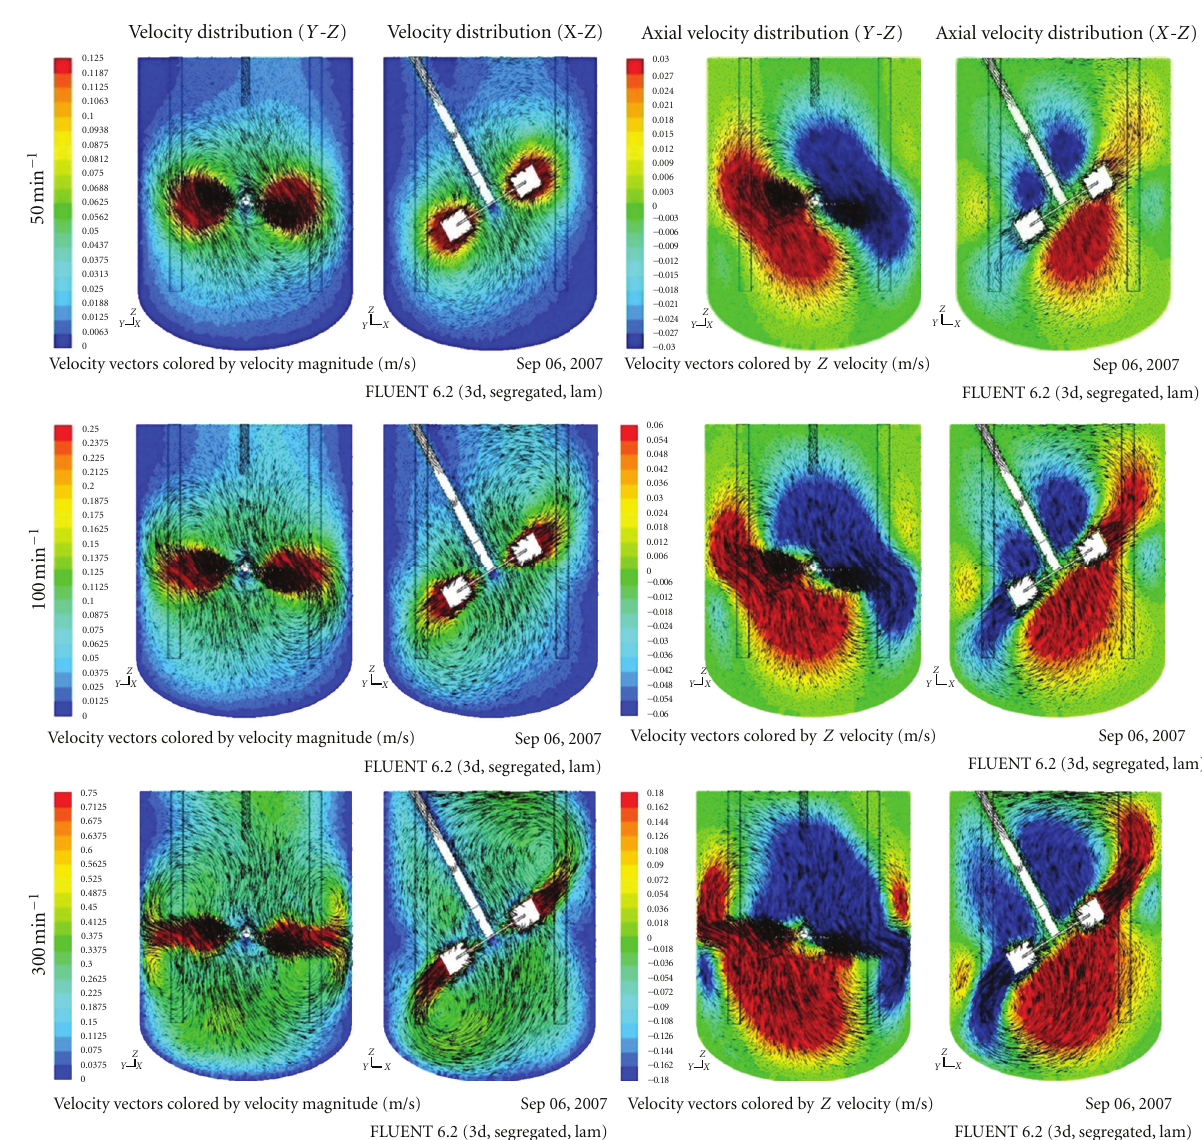
Figure 7: Three-dimensional flow velocity and axial velocity distribution (impeller inclined at 30 ◦ ). The rate vector was overlapped with each figure. The range of coloring was displayed in proportion to the rotational